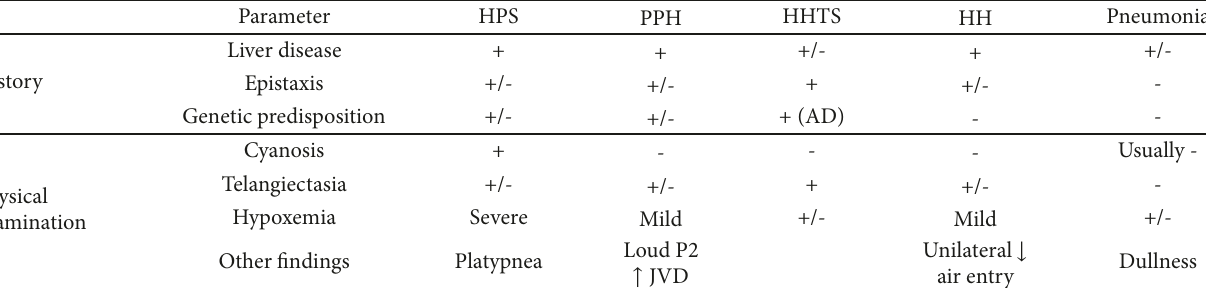
Table 1: Differential diagnosis of hepatopulmonary syndrome.